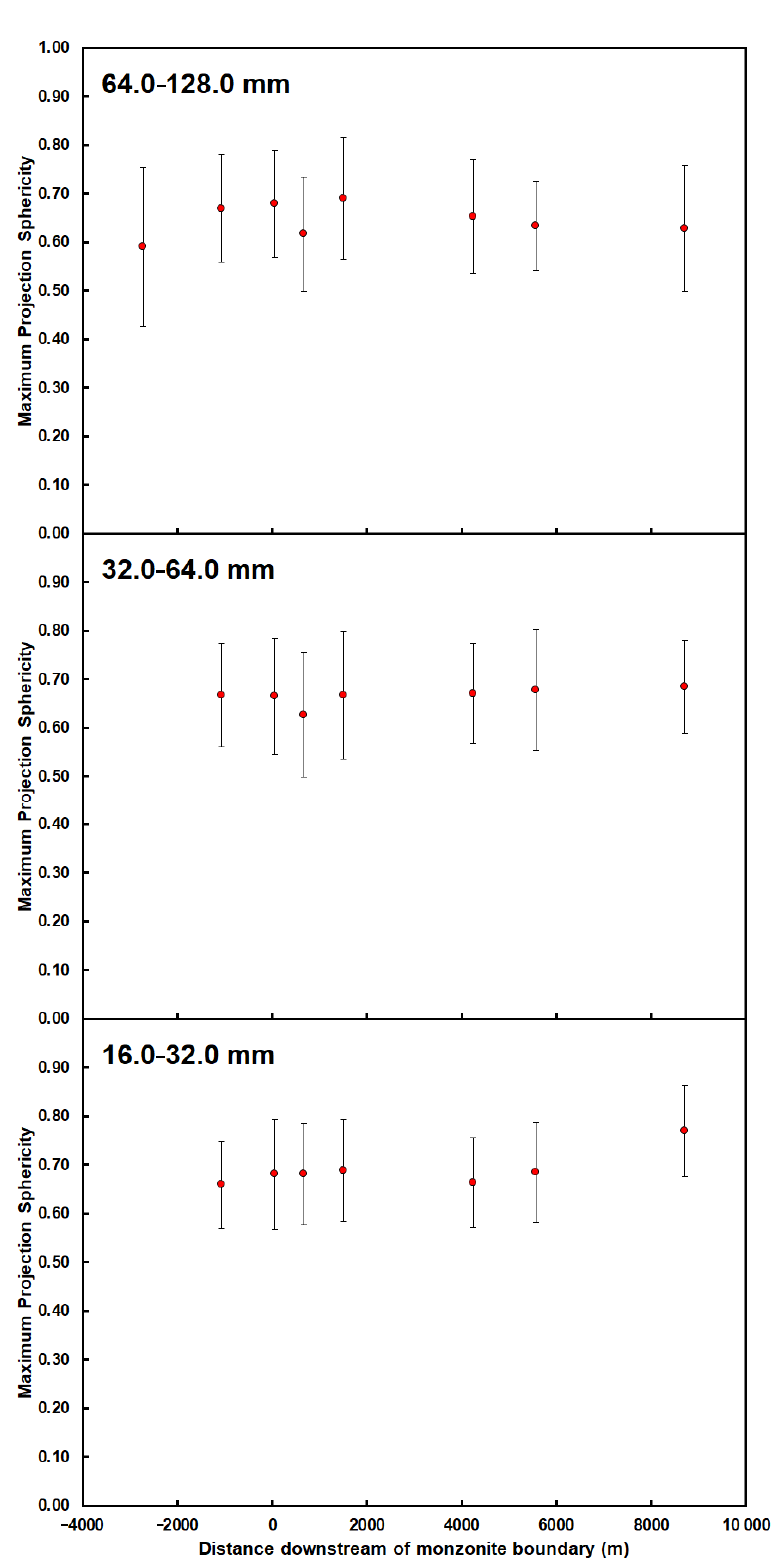
Figure 10. The mean Maximum Projection Sphericity of gravels of Navilawa Monzonite as a function of distance downstream of the boundary of the monzonite intrusion in the Sabeto River of western Viti Levu, Fiji. The data points are expressed with an uncertainty of ± 1 s .